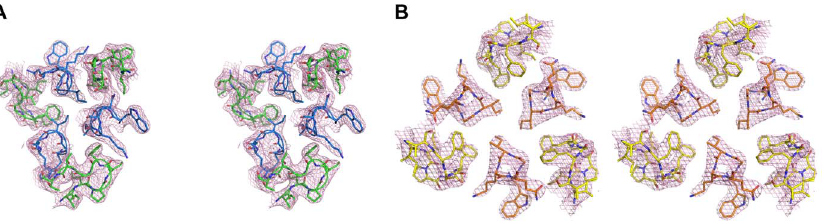
Figure 6. Electron density for the fragments of the structure comprising CDRs H2 of the Fabs and N helices of 3-H. The 2Fo-Fc maps are contoured at 1.0 s and are shown for the fragments of N helices comprising residues 571–575, and for CDRs H2 (residues 51–57). A) (Fab 8066) 3 / 3-H. Fab is green and 3-H is blue. B) (Fab 8062) 3 /3-H. Fab is yellow and 3-H is orange.